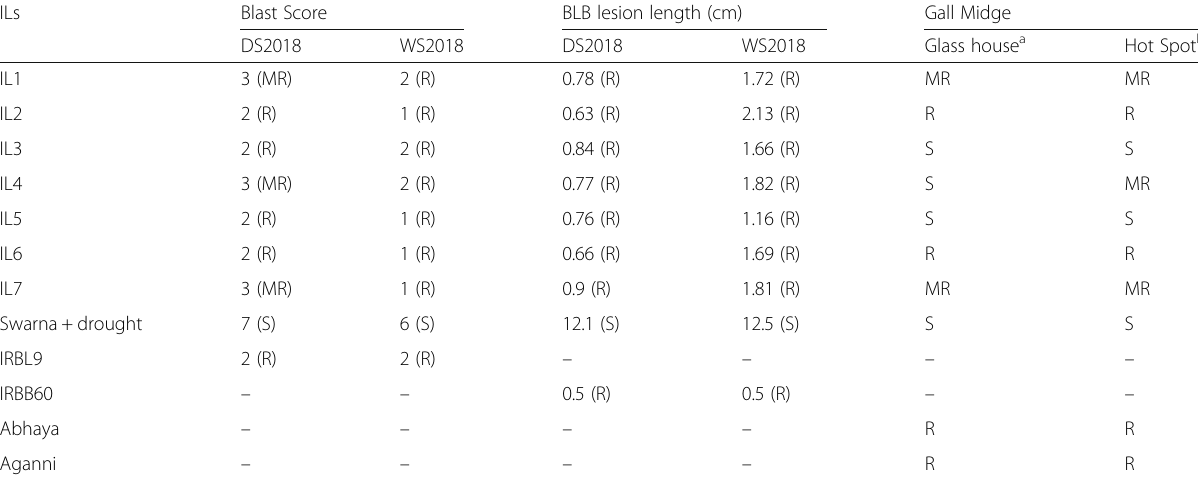
Table 3 Reaction of introgressed lines to blast, BLB and gall